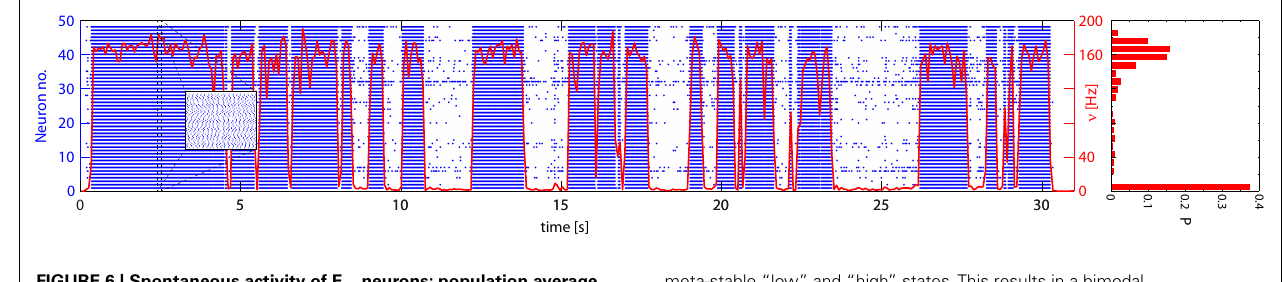
meta-stable “low” and “high” states.This results in a bimodal distribution of activity, as shown in the histogram on the right. Note that the average activity of individual neurons differs markedly, due to mismatch